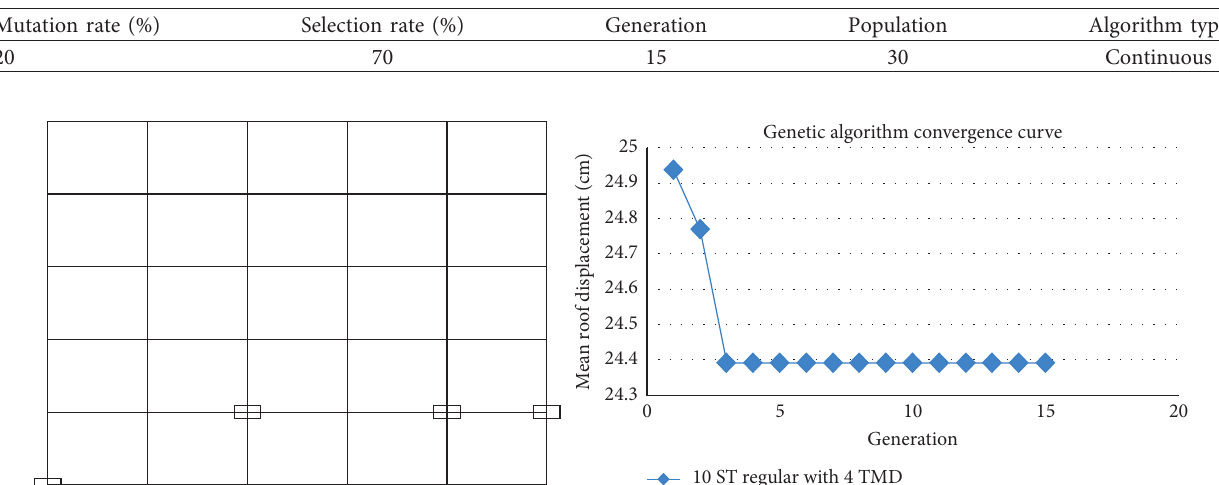
Table 11: Genetic algorithm parameters.